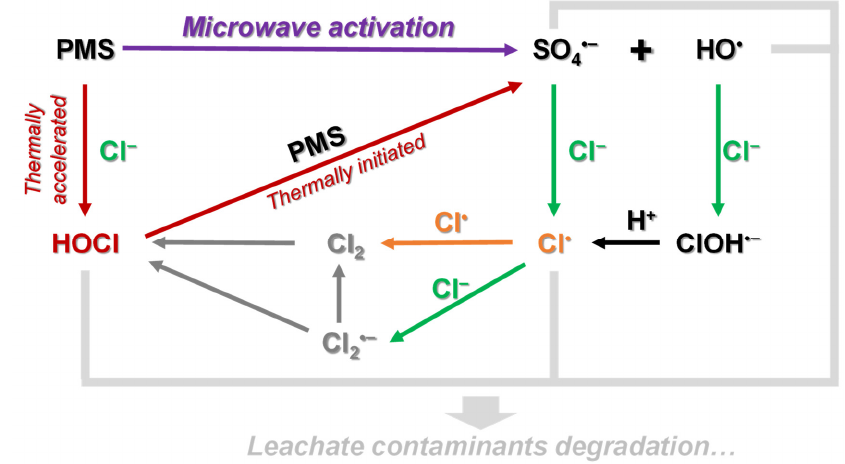
Figure 4. Proposed transformation pathways of Cl − in the MW/PMS system.